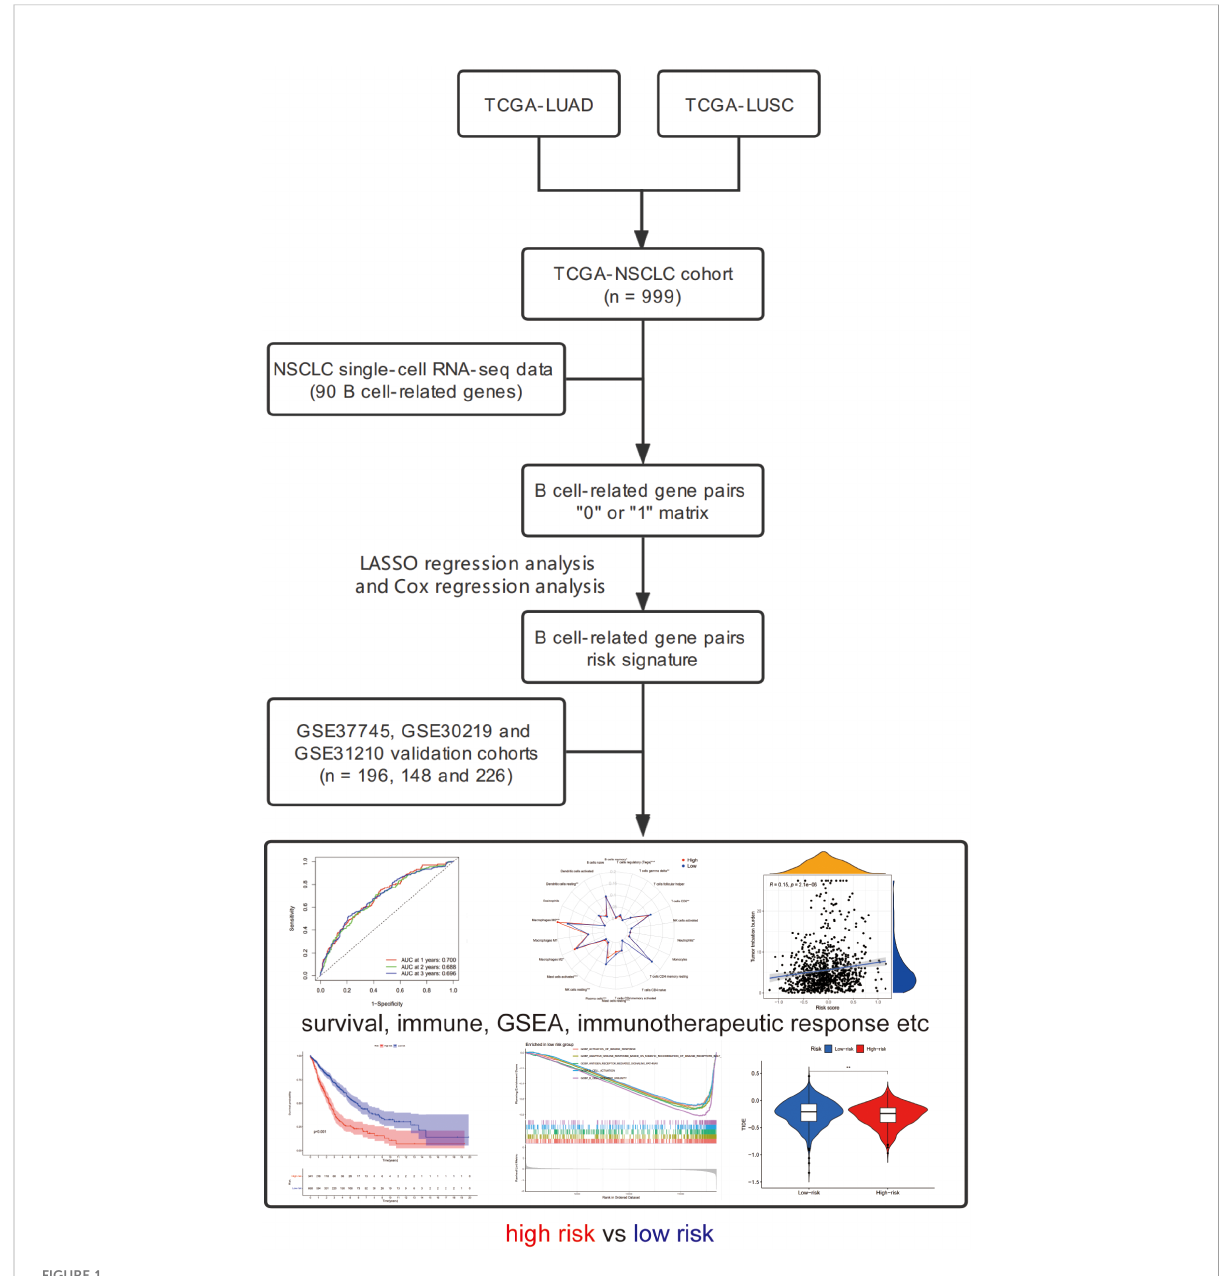
FIGURE 1 The fl owchart of this